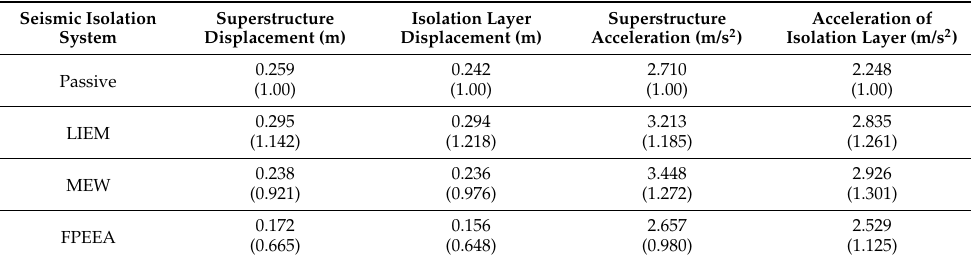
Table 8. Maximum responses of TCU068- EW earthquake (PGA = 0.2 g). Seismic Isolation